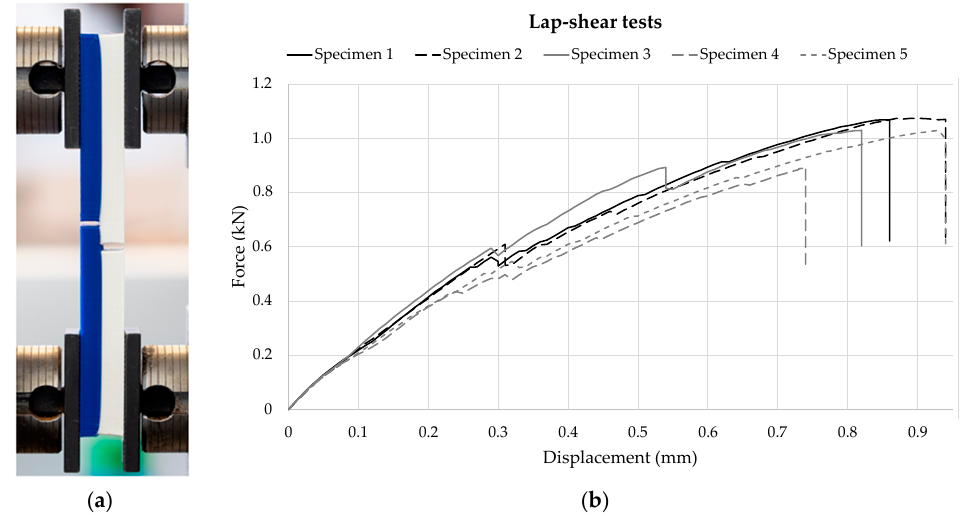
Figure 8. ( a ) Testing set-up of the lap-shear tests with the clamped multi-material test specimen made of PLA (white) and ABS (blue), and ( b ) corresponding force-displacement curve recorded by